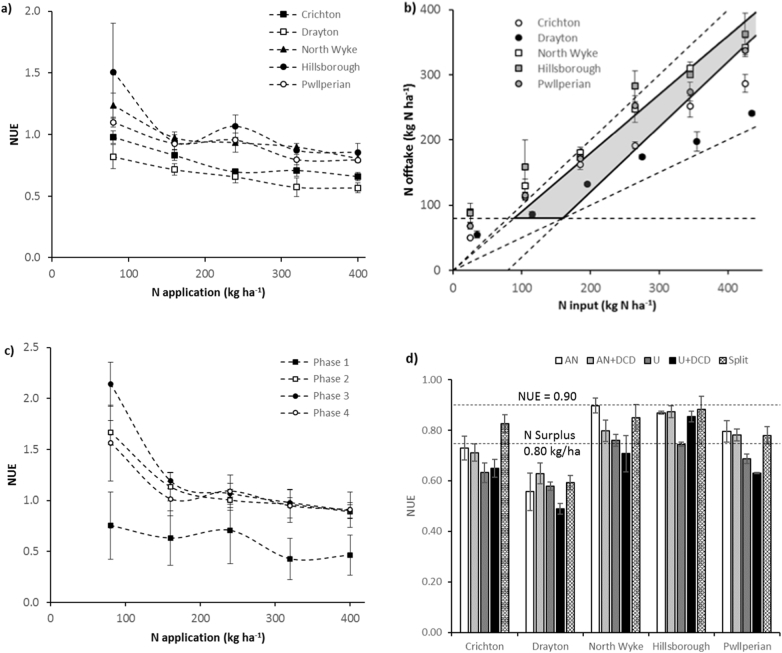
(a) Nitrogen use efficiency (NUE, kg N output/kg N input) as affected by nitrogen application rate at each site for the ammonium nitrate (AN) treatments; (b) the evaluation of NUE as affected by the N application rate, where N offtake is represented against N input (fertiliser N + atmospheric N deposition); the 90% and 50% NUE lines are represented, as well as the additional conditions of minimum offtake (80 kg N ha−1) and maximum surplus (80 kg N ha−1), also the shaded area represents the desirable range for NUE, N output and N surplus; (c) average NUE for all the sites for the AN treatments (excluding the changes in strategy) between successive fertilisation dates (phases 1, 2 and 3) and between the final fertiliser application and the final harvest (phase 4); and (d) effect of the application strategy for AN and urea at a rate of 320 kg N ha−1 on NUE in which the 90% NUE and 80 kg N ha−1 surplus (NUE = 0.75) thresholds are indicated as upper and lower dash lines, respectively.